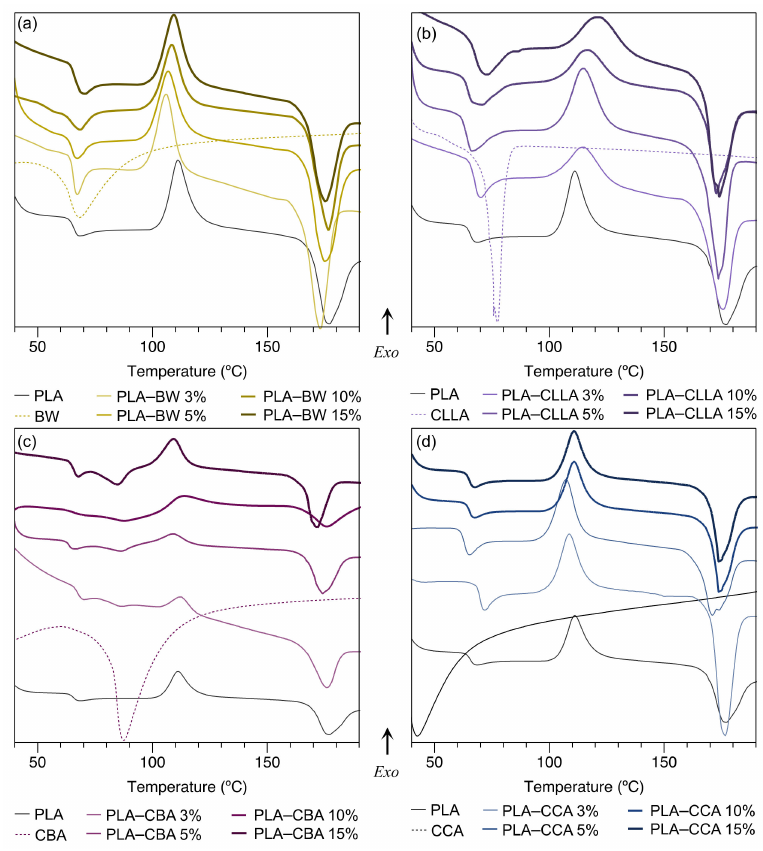
Figure 2. DSC thermograms of PLA–wax blends compared with PLA and its wax. ( a ) PLA–BW blend,